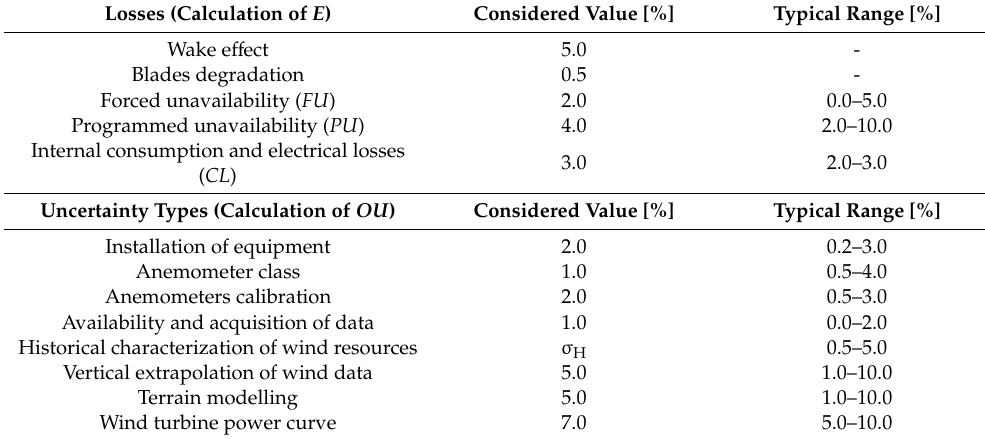
Table 4. Losses and